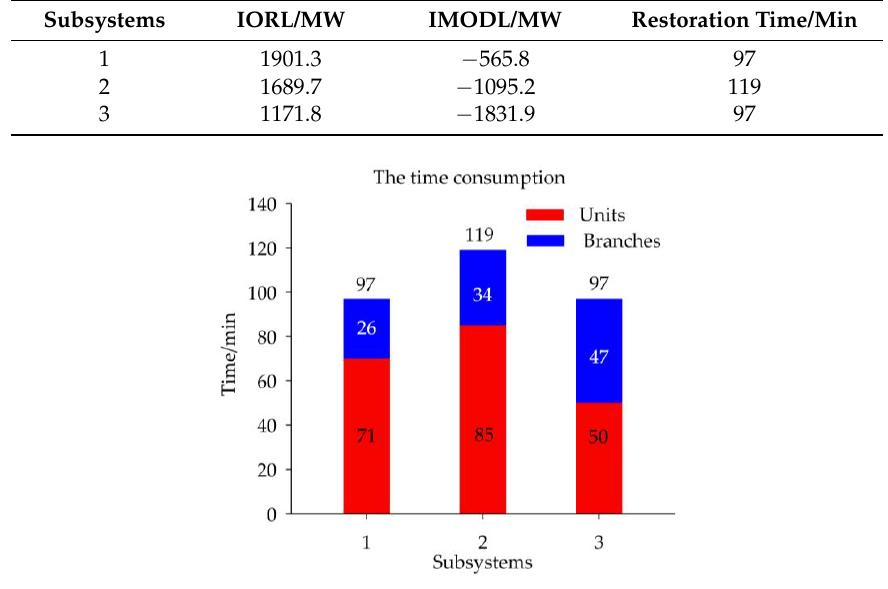
Figure 7. The restoration time consumption.